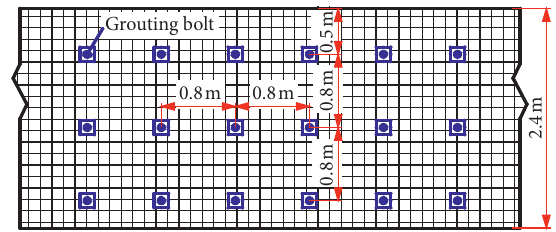
Figure 19: Elevation of grouting bolts in the wall of roadway.